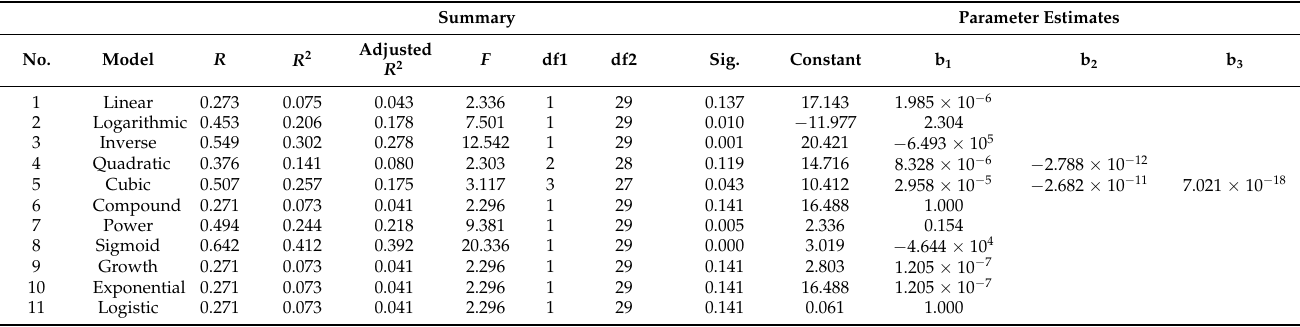
Table A3. Table A2. Summary and parameter estimates for all models (the provincial SUM of DN as an